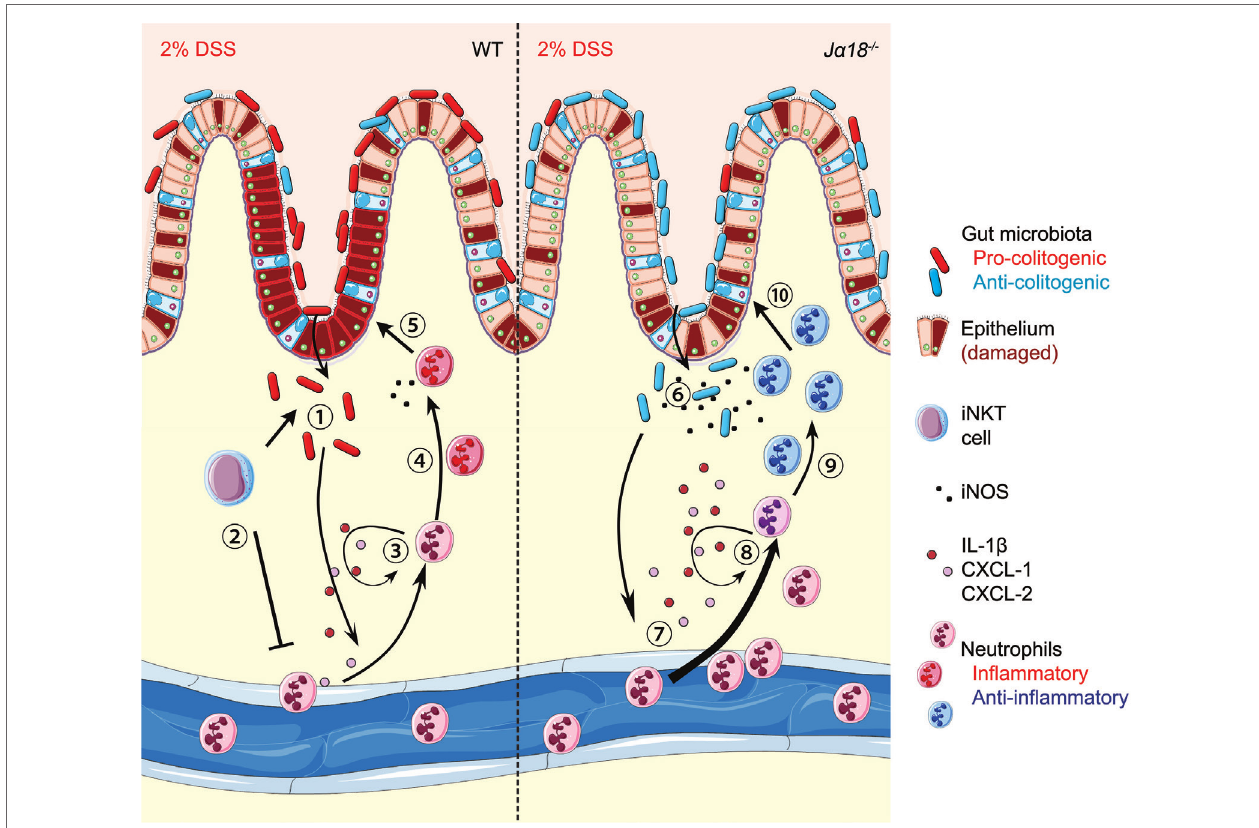
FigUre 7 | Schematic diagram showing the invariant natural killer T (iNKT) cell–microbiota–neutrophil axis in regulation of dextran sodium sulfate (DSS)-induced intestinal inflammation. (1) Continual administration of 2% DSS in wild-type (WT) mice results in epithelial damage and allows translocation of inherently pro-colitogenic gut bacteria. This results in local colonic inflammation, production of IL-1 β , CXCL1, and CXCL2, and the recruitment of immune cells, including neutrophils. (2) Antigen presentation of the translocated bacteria to iNKT cells acts to suppress exacerbated recruitment of neutrophils. (3) Once recruited, neutrophils produce IL-1 β , CXCL1, and CXCL2, which function in an autocrine manner for further recruitment. (4) In the highly inflammatory environment, neutrophils polarize toward a pro-inflammatory phenotype. (5) This inflammatory phenotype, in combination with low production of bactericidal iNOS, is detrimental and results in increased intestinal inflammation. (6) In J α 18 − / − mice, there is translocation of anti-colitogenic gut bacteria. (7) Without iNKT cells, there is earlier and more pronounced recruitment of neutrophils to the colon. (8) The recruitment is likely sustained due to the autocrine functions of IL-1 β , CXCL1, and CXCL2. (9) The presence of anti-colitogenic bacteria supports neutrophils to function toward an anti-inflammatory phenotype. (10) Increased production of iNOS by neutrophils enables dual bactericidal and immune-modulatory functions, thereby resulting in lower disease pathology. (Stock images sourced from Servier Medical Art; Creative